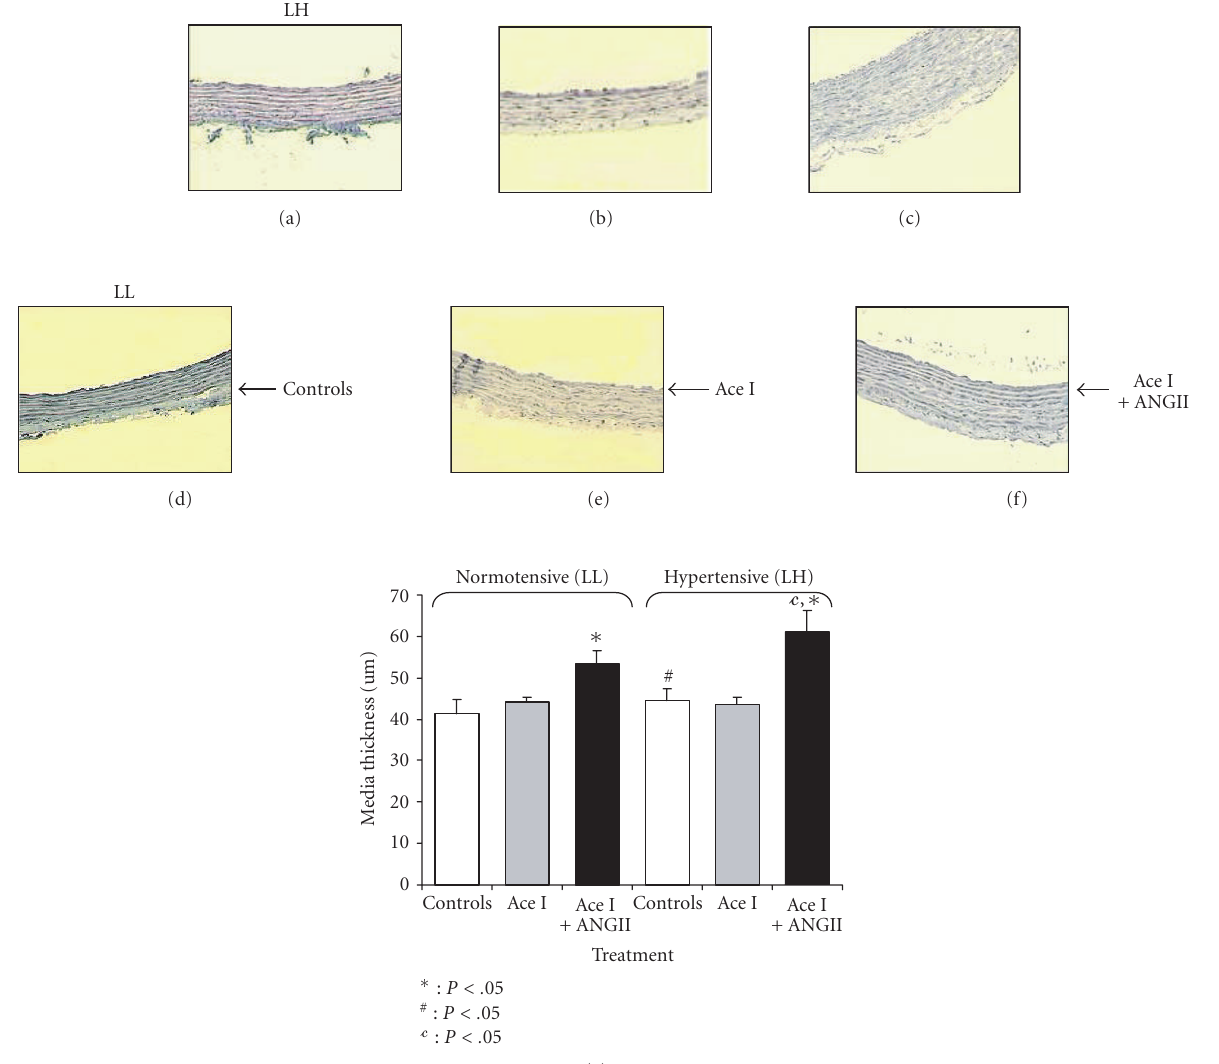
Figure 11: Analysis of media hypertrophy . Media thickness was determined, following haematoxylin/eosin staining of aorta sections. (a) Control LH rats were studied for their media thickness. (b) AceI treated LH rats were also analysed. (c) AceI and ANGII treated LH rats. (d) Control LL rats. (e) AceI treated LL rats. (f) AceI + ANGII treated LL rats. (g) Quantification of the above data is presented as means ± SEM ∗ : P < . 05 versus controls for each strain. # : P < 0 . 05 versus normotensive controls rats, c : P < . 05 versus AngII-perfused normotensive